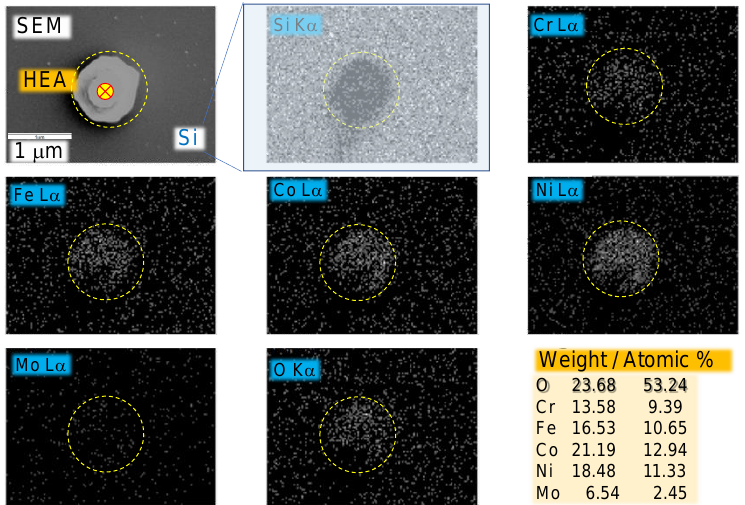
Figure 7. X-ray energy-dispersive spectroscopy (EDS) mapping of a microparticle of CoCrFeNiMo 0.2 on Si substrate (Oxford on Zeiss SEM